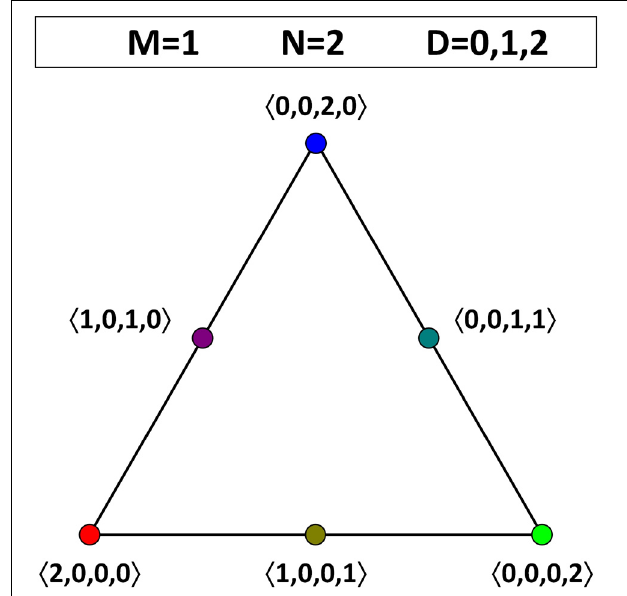
FIGURE 2 | Opinion dynamics for theories in a language with one atomic proposition ( M = 1) and a population consisting of two agents ( N = 2). One face of the OPS is shown. Irrespective of the value of the threshold D ( D is equal to 0, 1, or 2), all opinion profiles are fixed points (including the ones not